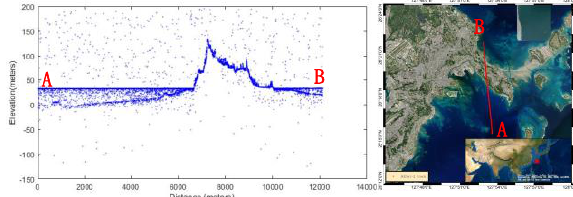
Figure 7 . Schematic diagram of the research area. The figure on the left is the data profile of ICESat-2. The figure on the right is a plan view of the study